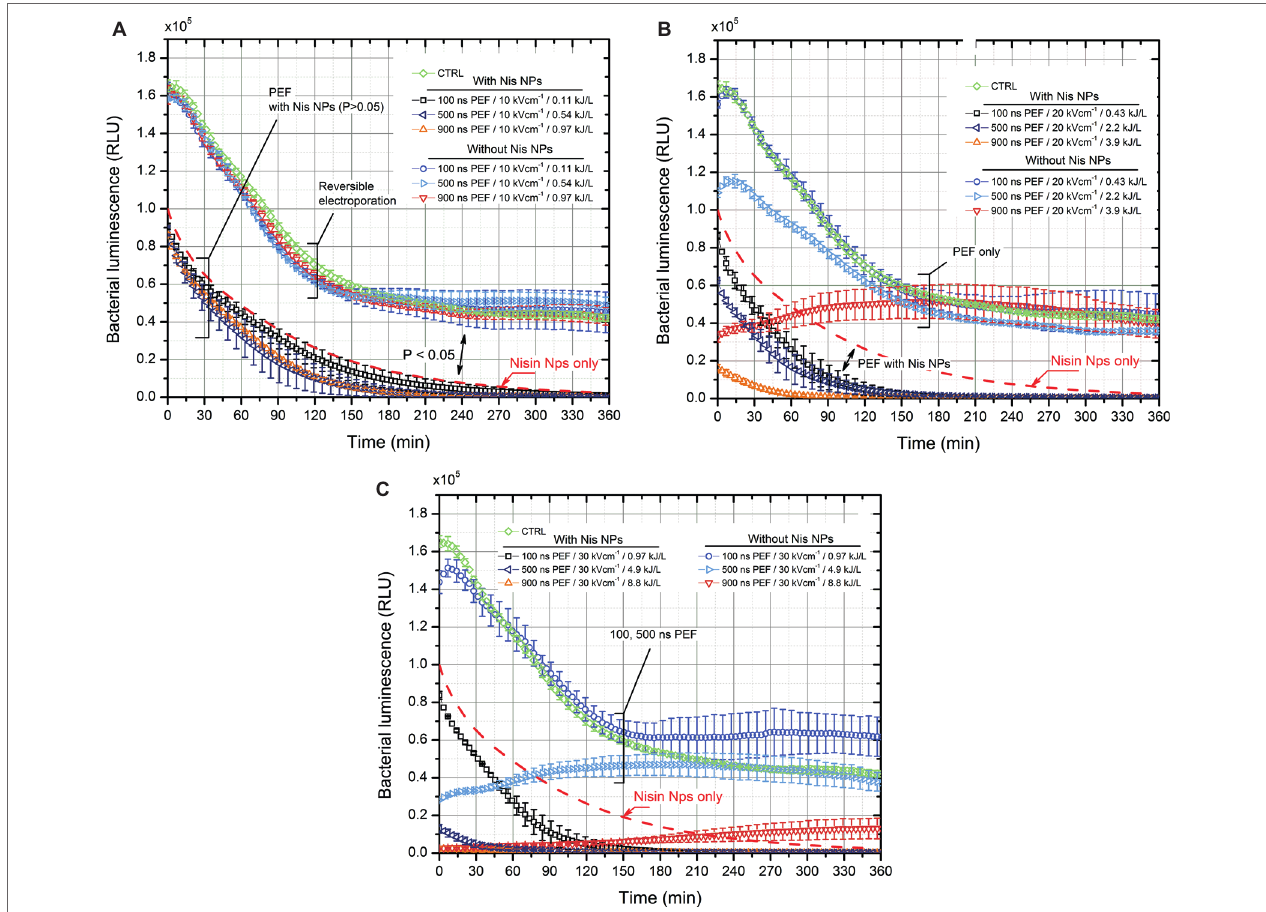
FIGURE 5 | The dependence of bacteria luminescence on the applied combined pulsed electric field (100–900 ns × 500) and nisin nanoparticles (0.2 mg/ml) treatment, where (A) 10 kV/cm protocols; (B) 20 kV/cm protocols; (C) 30 kV/cm protocols; CTRL–corresponds to untreated control without nisin nanoparticles; dashed line is used as a reference to highlight the efficacy of nisin nanoparticles only